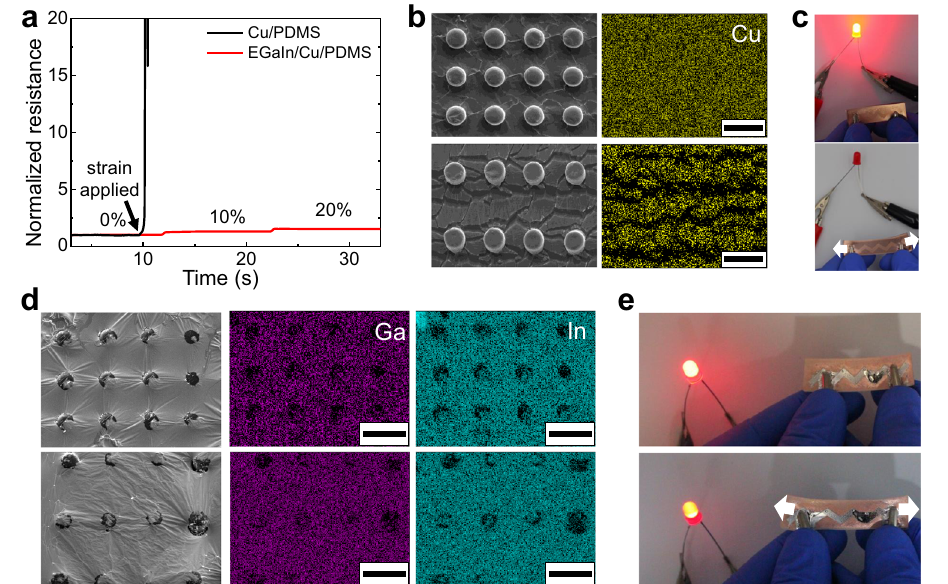
Fig.5|EffectofstrainontheelectricalstabilityofpristineCu/PDMSandEGaIn- coated Cu/PDMS (EGaIn/Cu/PDMS). a Change in the normalized resistance with increasing strain on Cu/PDMS and EGaIn/Cu/PDMS. b , d SEM images and energy- dispersiveX-ray spectroscopy(EDS)analysisbefore(top)and after(bottom)strain